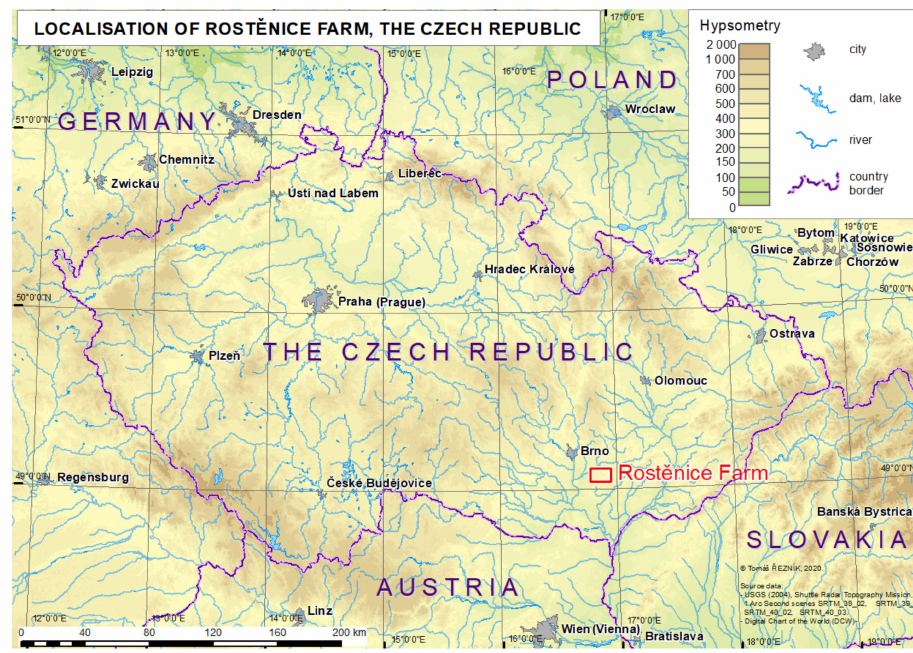
Figure 2. Geographical location of the Rostˇenice Farm.